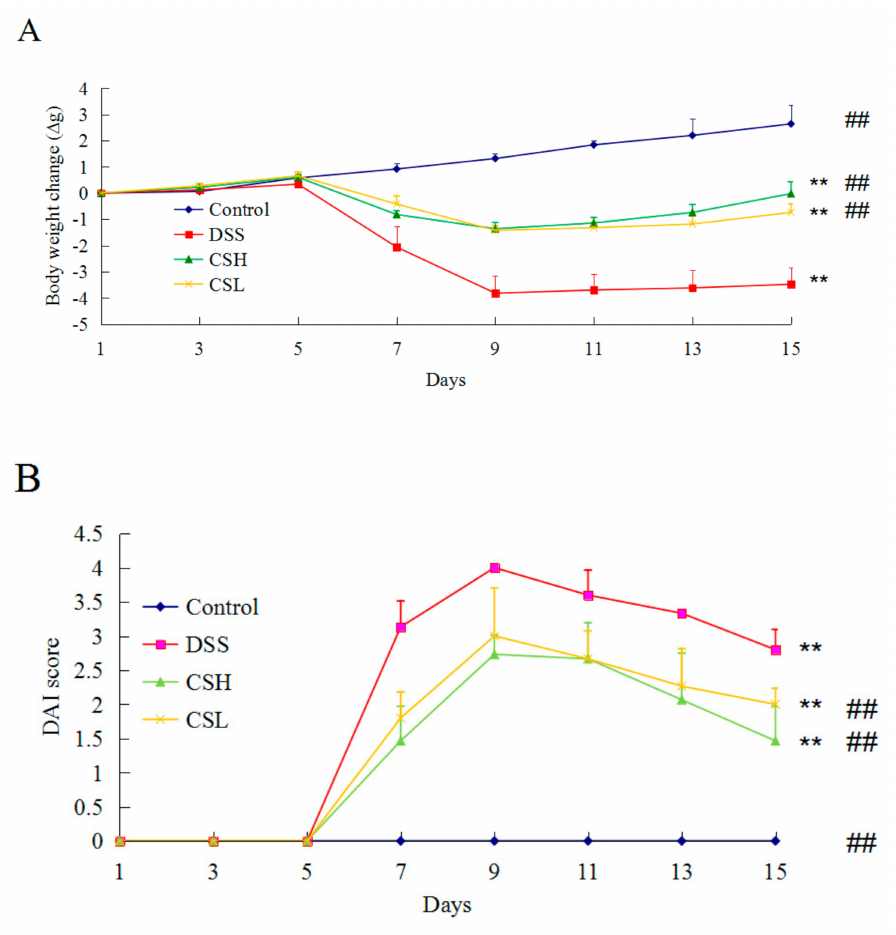
Figure 1. E ff ects of CS on body weight ( A ) and the disease activity index (DAI) ( B ) in DSS-induced UC mice. Control: normal mice; DSS: mice treated with 3% DSS alone; CSH: mice treated with DSS plus chitosan (250 mg / kg); CSL: mice treated with DSS plus chitosan (150 mg / kg). Values are expressed as mean ± SD ( n = 10). ** p < 0.01 versus control; ## p < 0.01 versus